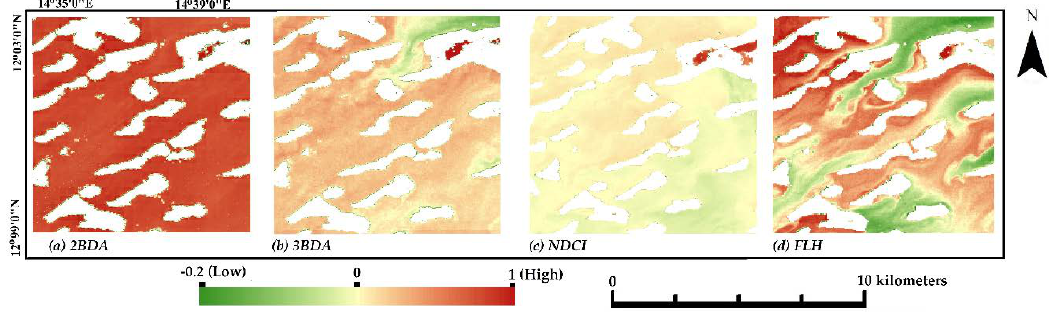
Figure 7. Chl a extraction from L8 image. All the index products were derived at 30-m spatial resolution. Increasing concentrations of Chl a are depicted by brighter pixels.